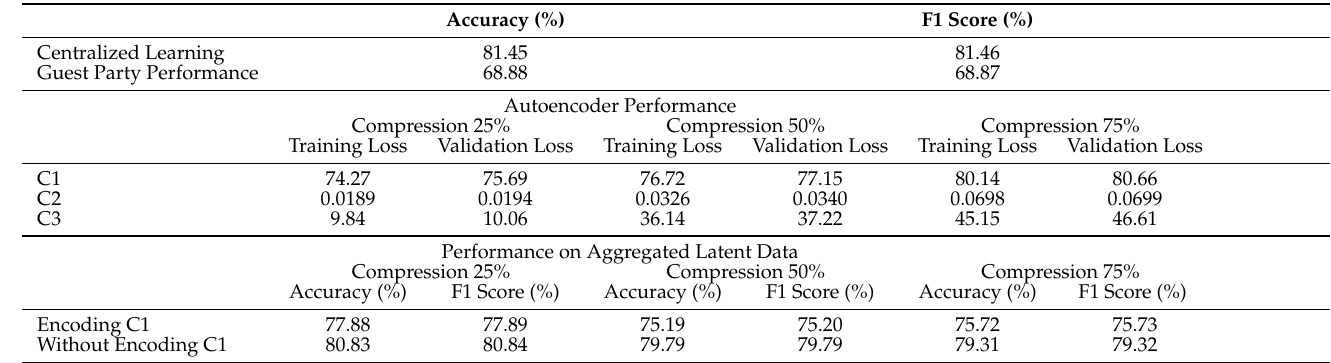
Table 6. Experimental Results on Adult Income